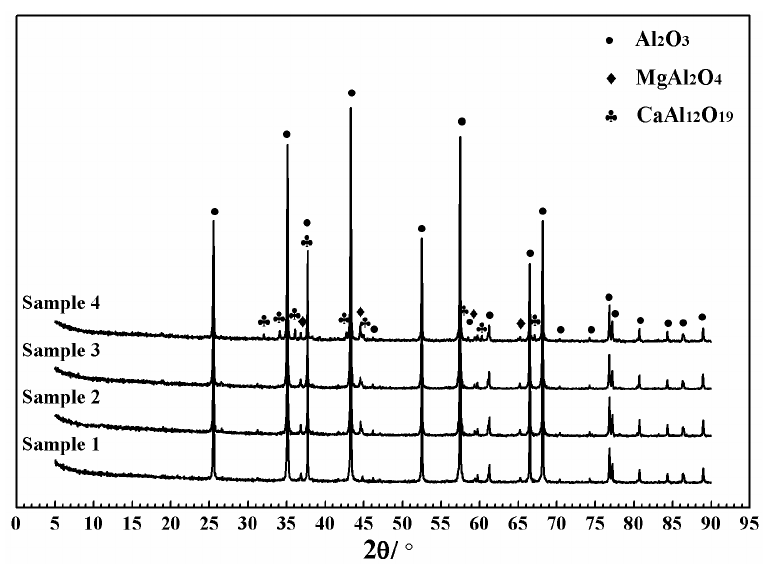
Figure 2. Powder X-ray diffraction patterns of samples with different Gd 2 O 3 concentrations (Sample 1: 0 wt%; Sample 2: 0.01 wt%; Sample 3: 0.1 wt%; Sample 4: 1 wt%).